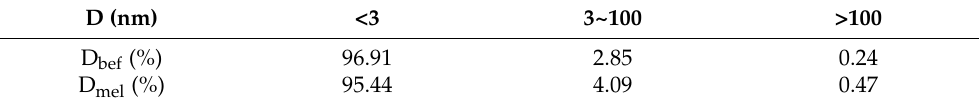
Table 1. Pore distribution of soil samples before and after freezing and thawing.